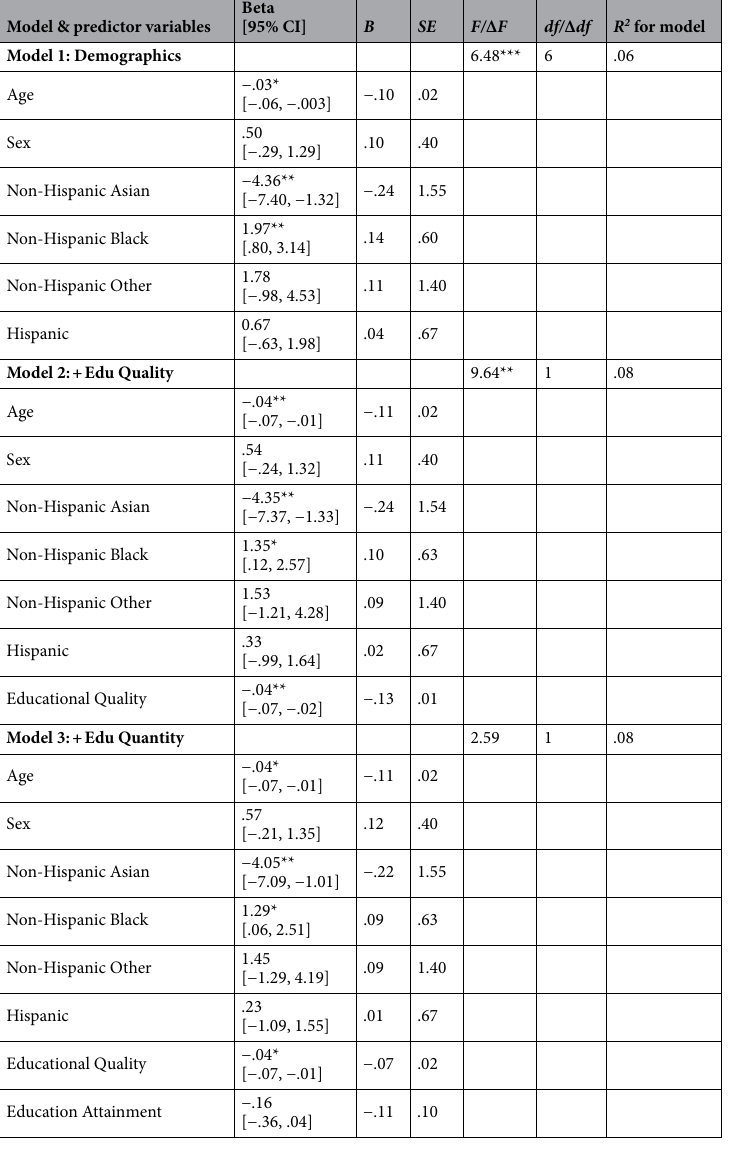
Table 4. Results of regression models predicting BMI in HCP−A data set. * p < .05, ** p <